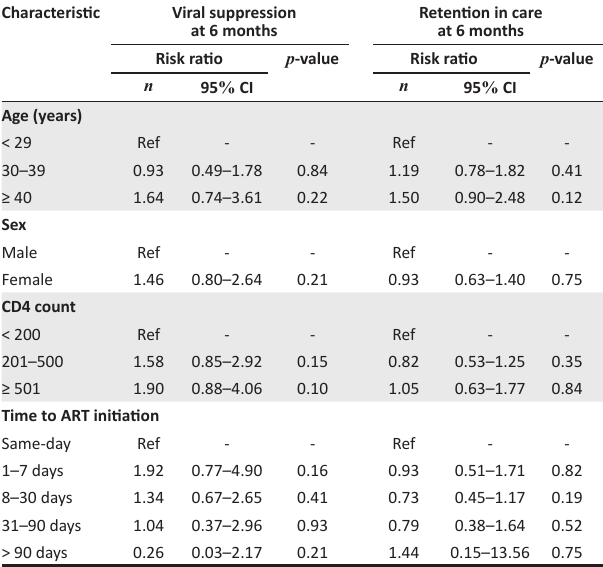
TABLE 4: Log-binomial logistic regression adjusted for age, gender, CD4 count and antiretroviral therapy initiation group.